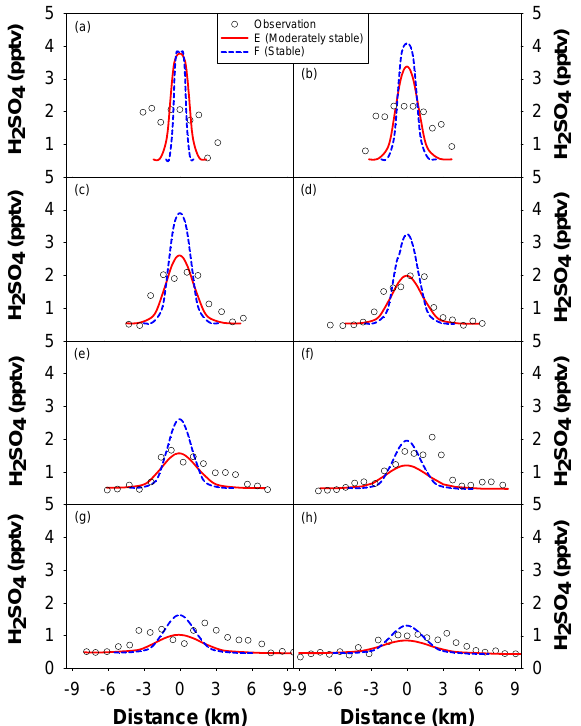
Fig. 7. As Fig. 4, except for HNO 3 . γ HNO this study.